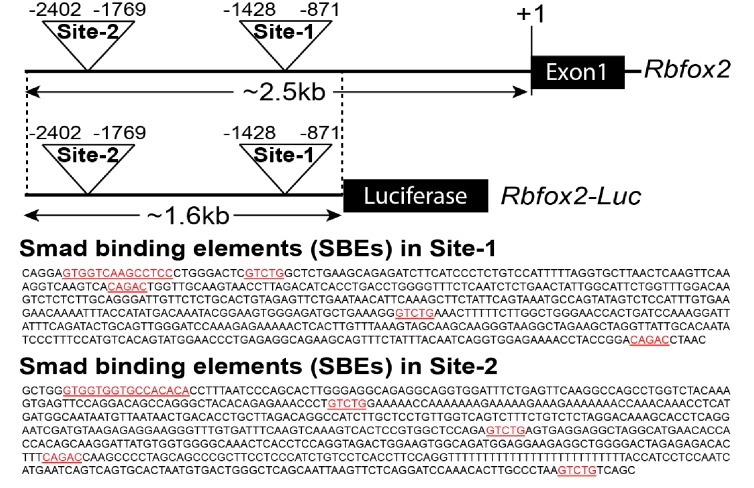
Rbfox2 promoter analysis.Predicted sites (Site1 and Site2) in 2.5 kb Rbfox2 promoter containing Smad binding elements (SBEs). Schematic of the Rbfox2-luciferase (Luc)-reporter construct. Multiple SBEs present in predicted sites (Site1 and Site2) are highlighted in red color.